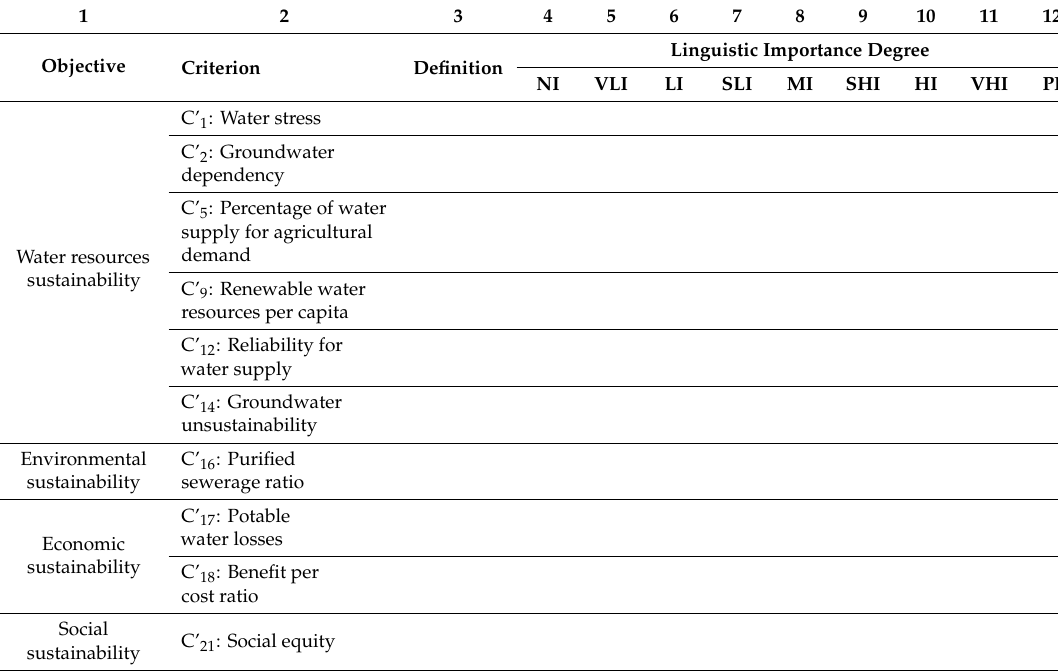
Table A5. Sample questionnaire for the linguistic importance degrees of the final